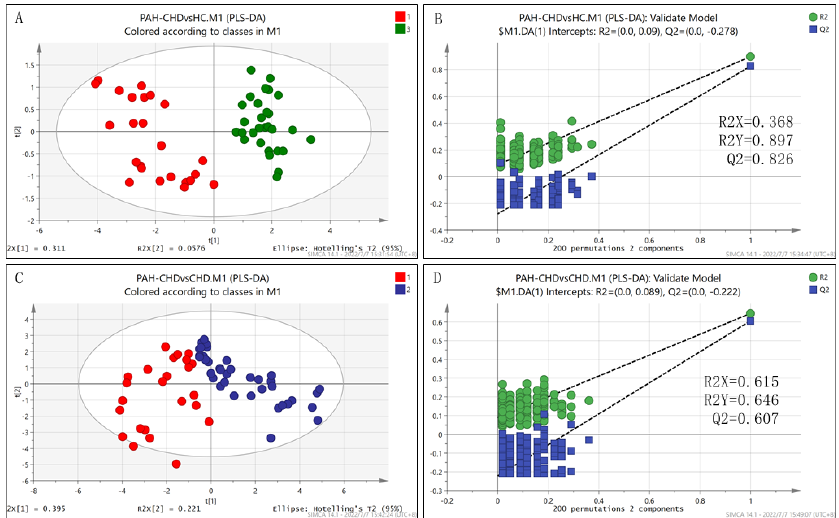
Figure 2. The scores plots of PLS − DA models and validations for pair-wise comparisons of the three groups. ( A , B ) PAH − CHD vs. HC; ( C , D ) PAH − CHD vs. CHD. groups. ( A , B ) PAH − CHD vs. HC; ( C , D ) PAH − CHD vs.